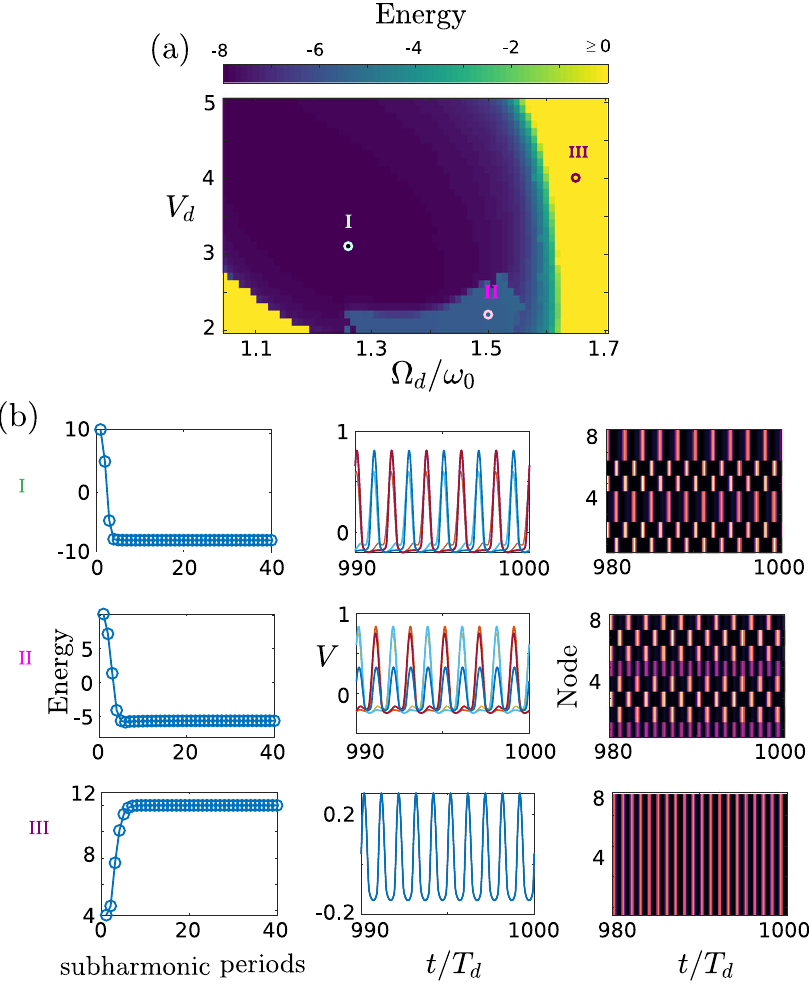
Fig. 8 Exploring numerical parameter space. a Dependence of the fi nal energy for the Möbius-ladder network (Fig. 4) on the driving frequency ω d and the driving amplitude V d . We observe the existence of three qualitatively different regions (dark blue, blue-green, yellow), which are marked with the representative data points I ( ω d = 1.26 ω 0 , V d = 3.1 V), II ( ω d = 1.5 ω 0 , V d = 2.2 V) and III ( ω d = 1.65 ω 0 , V d = 4 V). The ensuing dynamics at the I,II,III points is shown in the three rows of ( b ). In particular, the fi rst column shows the time evolution of the energy at the I, II, III points, whereas the second and third columns depict the corresponding circuit response at late